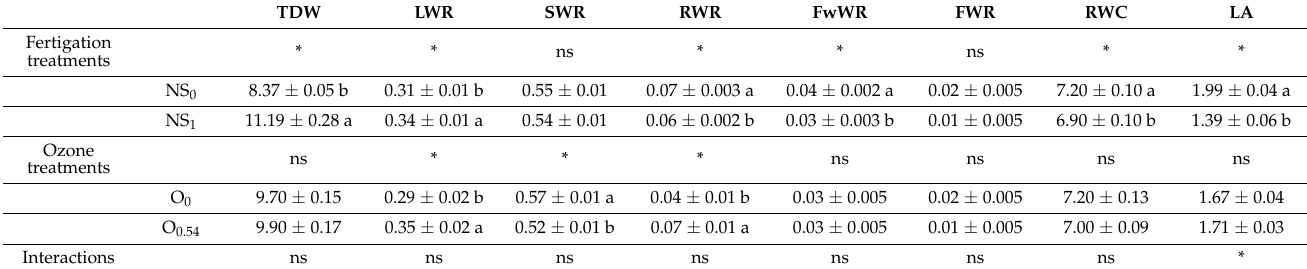
The leaf area of tomato plants was modified by the fertigation (NS 0 and NS 1 ) and O 3 (O 0 and O 0.54 ) treatments (Figure 2). Regarding nutrient solution, leaf area showed the highest value at O 0.54 . Regarding ozone concentration, the highest values were greater in tap water (NS 0 ).